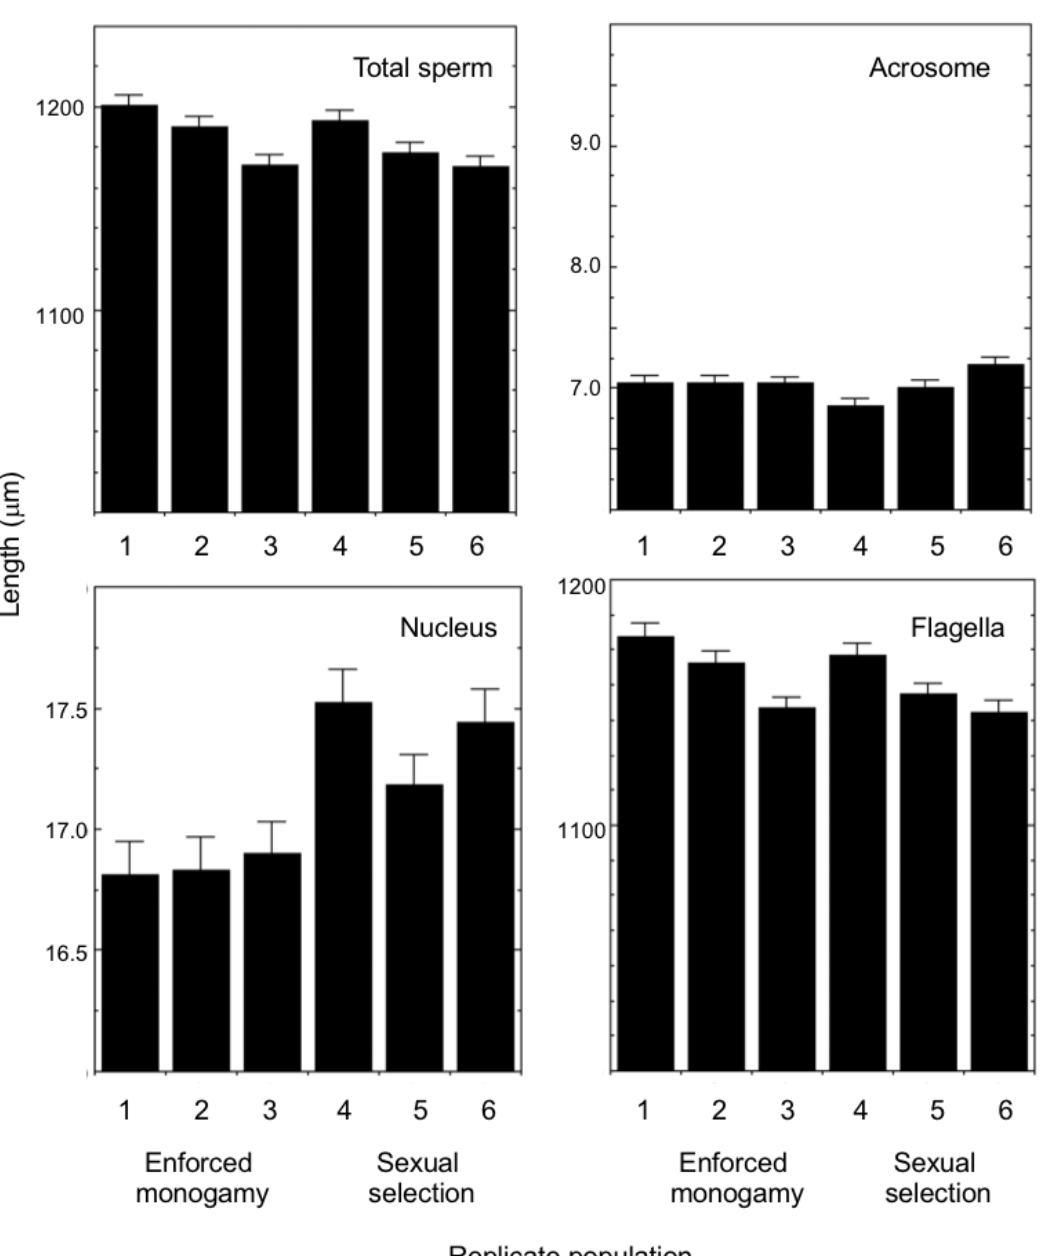
Figure 3. Mean ( ± SE) total sperm length, and lengths of the acrosome, nucleus, and flagella of males derived from three Figure 3. Mean (±SE) total sperm length, and lengths of the acrosome, nucleus, and flagella of replicate populations that had been evolving under enforced monogamy (1–3) and three replicate populations that had been males derived from three replicate populations that had been evolving under enforced monogamy evolving under sexual selection (4–6) for 20 (1 – 3) and three replicate populations that had been evolving under sexual selection (4 – 6) for 20 generations.